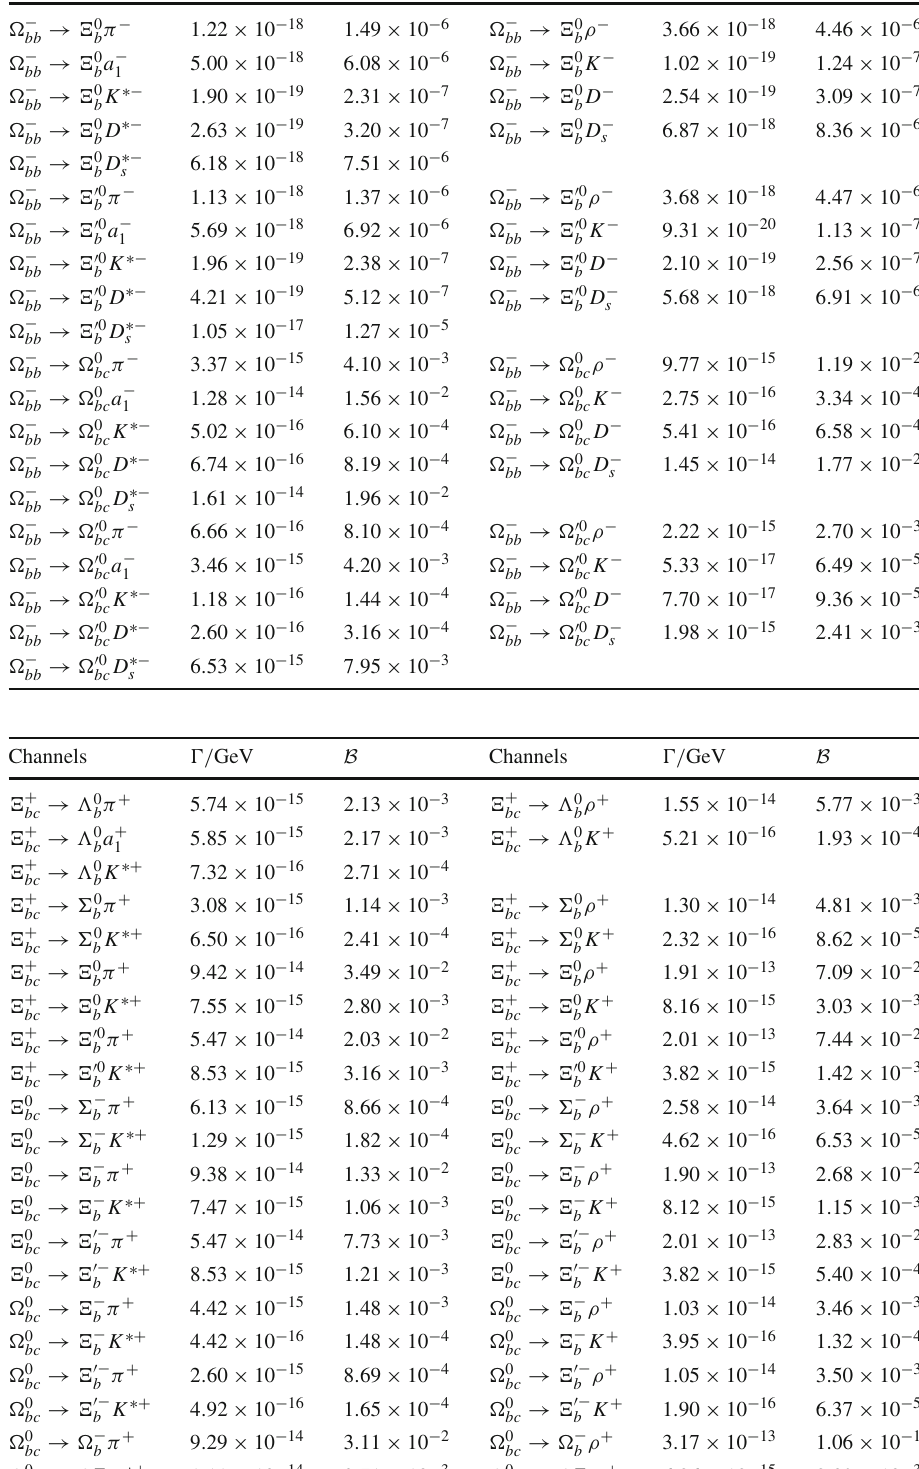
Table 25 Partial decay widths and branching ratios for nonleptonic decays of (cid:5) −